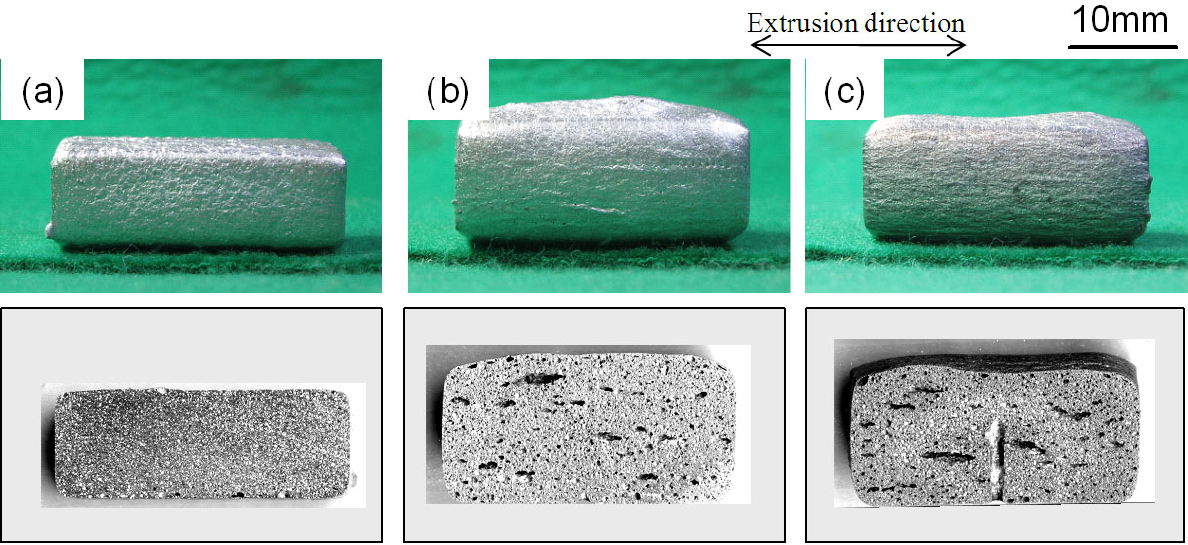
Figure 6. Foams produced using 2.0 mass% dolomite and 1.0 mass% MgCO cross sectional views: ( a ) at 903 K, ρ : 0.87 g/cm 3 , ( b ) at 933 K, ρ : 0.58 g/cm 3 , and ( c ) at 973 K, ρ : 0.66 g/cm 3